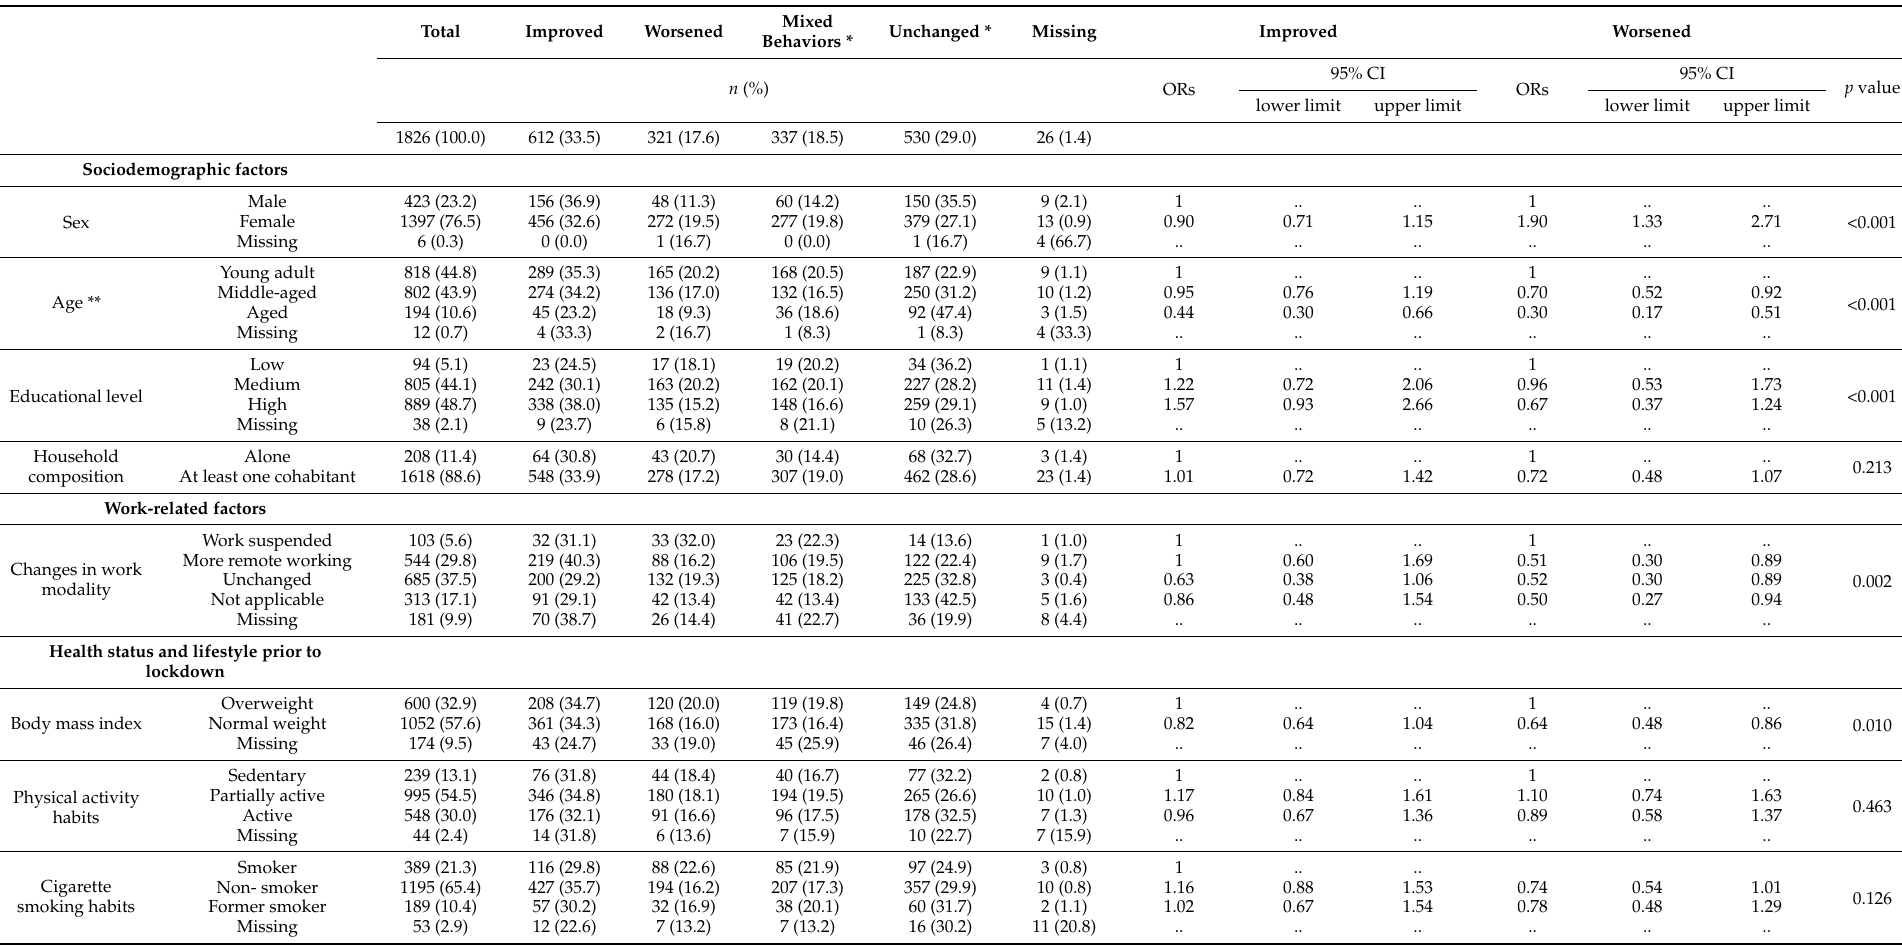
Table 3. Odds ratio for type of change in diet (improved, worsened, mixed behaviors, or unchanged) during COVID-19 lockdown by sociodemographic and work-related factors, health status, and lifestyle prior to lockdown, and psychological